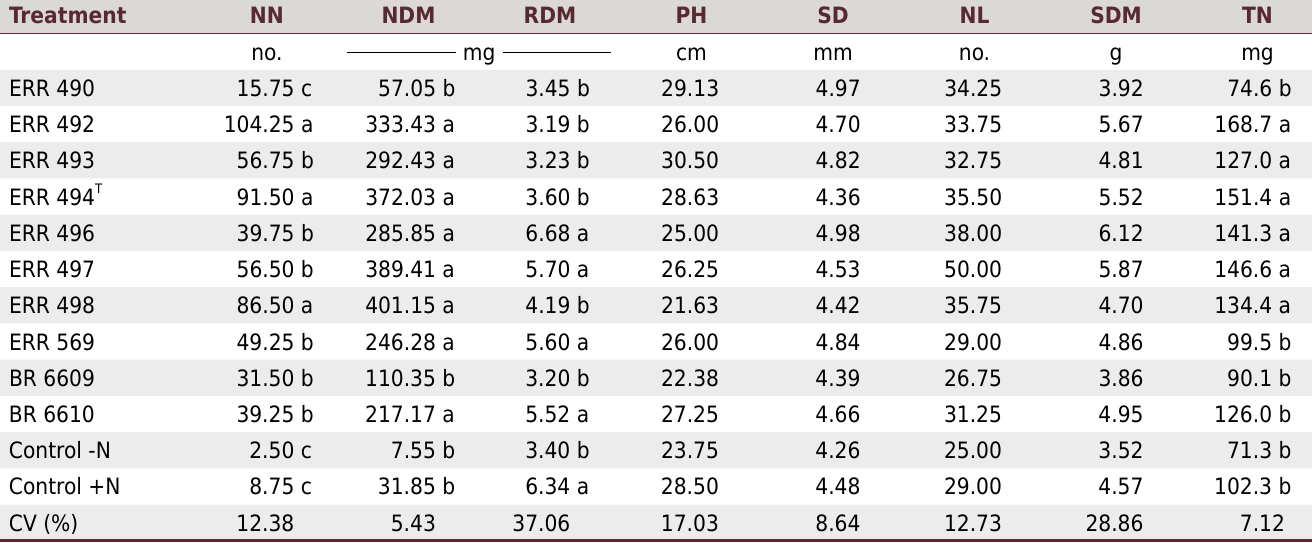
Table 2. Inga edulis Mart. response to inoculation with Bradyrhizobium ingae strains under greenhouse conditions in pots with non-sterile soil for 100 days (Experiment 2)